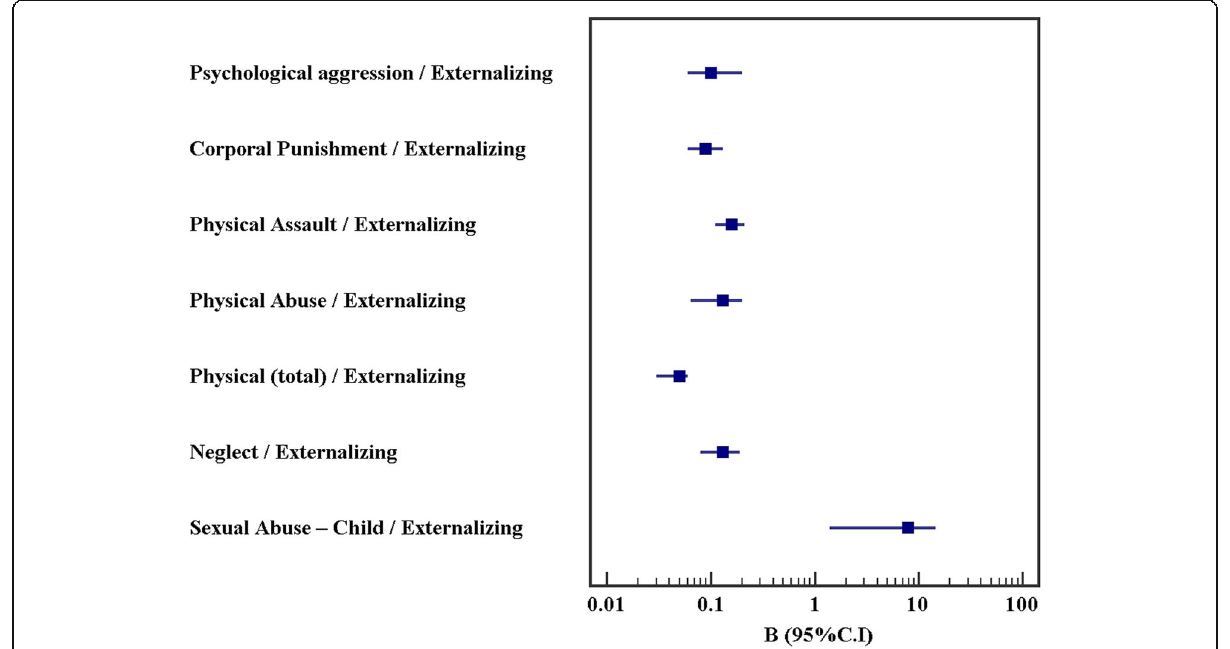
Fig. 2 Univariate linear regression for predictor variables significantly affecting CBCL externalizing problems scale